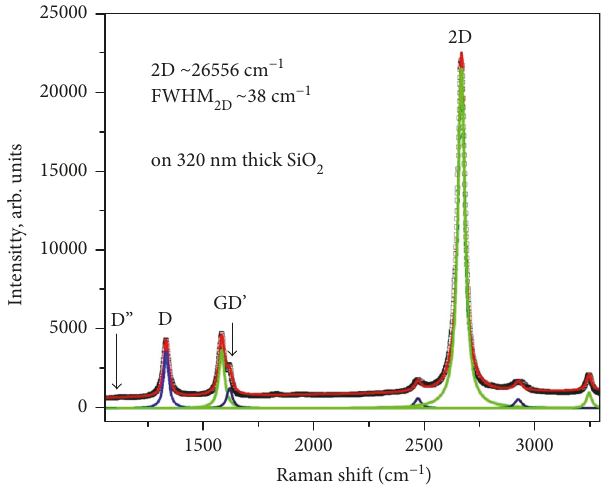
Figure 4: The Raman spectrum of defected 1-2-layered graphene transferred on 320nm SiO . The 2D band is symmetric and 2 appears at 2658-2659cm − 1 with FWHM of 38 – 40cm − 1 (measured in point 2) and 40 – 42cm − 1 (measured in point